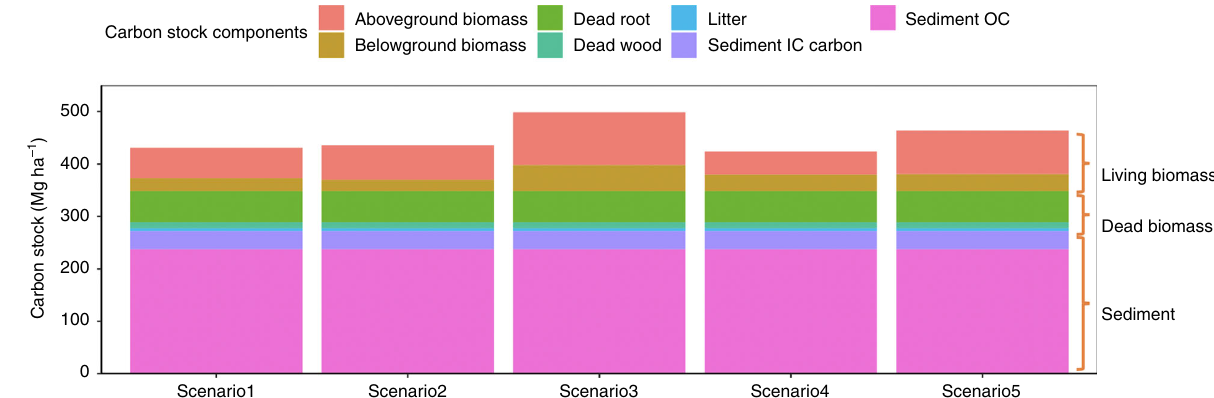
Fig. 4 Global ecosystem carbon stocks for mangroves. Living biomass (aboveground and belowground biomass) carbon stocks in the fi ve scenarios are cited from Simard et al. 20 , Tang et al. 54 , Hamilton and Friess 27 , Twilley et al. 55 , and Hutchison et al. 56 , while other components of carbon stock come from the same source. The unit of carbon stock is Mg ha −